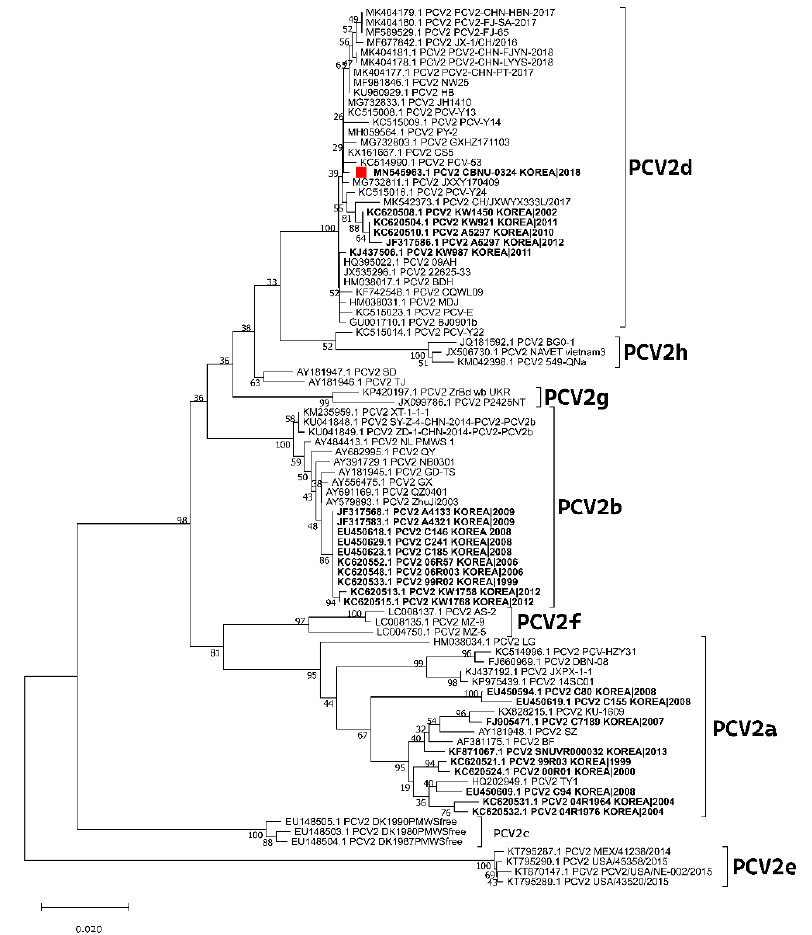
Figure 1. Maximum likelihood (ML) phylogenetic tree of the PCV2 ORF2 gene. The tree was generated using MEGA X software with 1000 bootstrap replicates. The PCV2d isolate used in this study (CBNU0324) is indicated with a red square symbol.